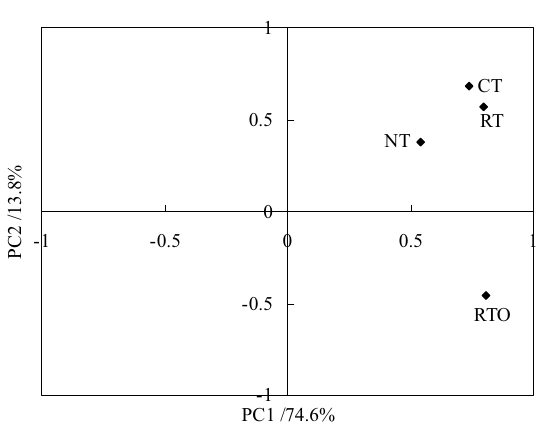
Figure 4. PCA showing variation in PLFAs composition with different tillage treatments. CT conventional tillage with crop residue incorporation; RT rotary tillage with crop residue incorporation; NT no-tillage with crop residue retention; RTO rotary tillage with crop residue removed as a